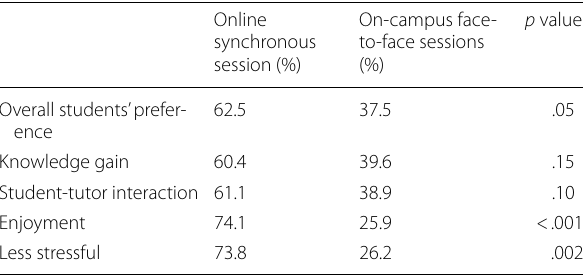
Table 4 Students’ preference of mode of learning in